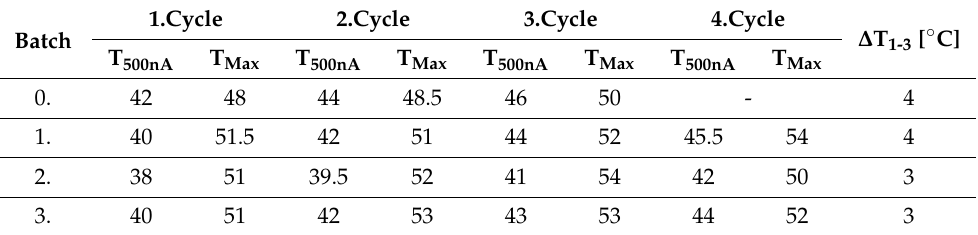
and the maximum temperature. The batch 0 is related to the measurement shown in Figure 6; the others are related to new chambers for field application (four chambers per batch). This procedure with 4 heat cycles has become a part of the construction.